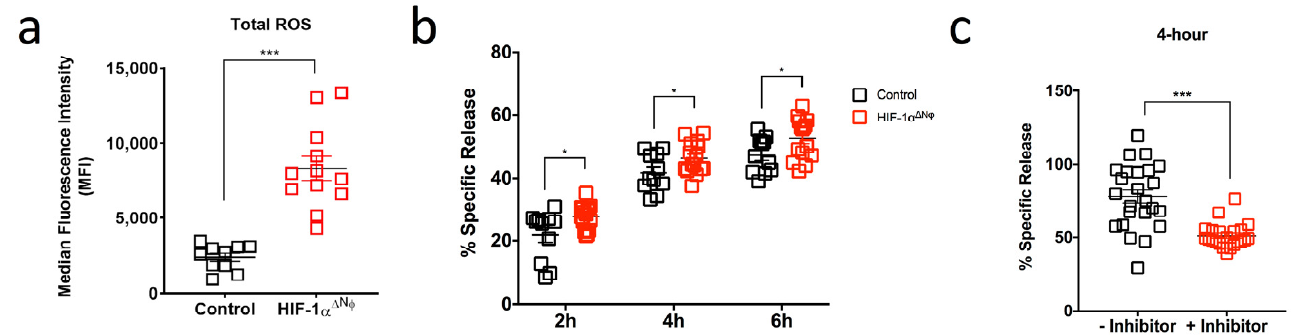
Figure 5. HIF-1 αΔ N φ neutrophils exert direct anti-tumoral effects ( a ) Scatter plot of reactive oxygen species (ROS) production (MFI) in HIF-1 αΔ N φ orthotopic transplanted (OT) and control OT pancreatic neutrophils (HIF-1 αΔ N φ n = 12 mice, littermate HIF-1 α fl/fl controls n = 10; three independent experiments). ( b ) Neutrophils were sorted based on their expression of Dapi-CD45 + Lin(CD3/B220/NK1.1) − Ly6G + Ly6C+. Scatter plot shown indicates the cytotoxic capacity of HIF-1 αΔ N φ neutrophils at a 10:1 effector:target (E:T) cell ratio after 2, 4 and 6 h incubation with 1242 L tumor cells ( n = 5 mice/group; n = 3 replicates). ( c ) HIF-1 αΔ N φ neutrophils were assessed for their cytotoxic capacity via ROS production. Neutrophils were treated with 5 mM N-acetyl-L-cysteine for 30 min at 37 °C. Scatter plot shown indicates the cytotoxic capacity of HIF-1 αΔ N φ neutrophils at a 10:1 E:T ratio after 4 h incubation with 1242 L tumor cells ( n = 5 mice/group; n = 3 replicates). Data represent the means ± SEM, * p < 0.05; *** p < 0.001 by unpaired Student’s t -test with 95% confidence interval.